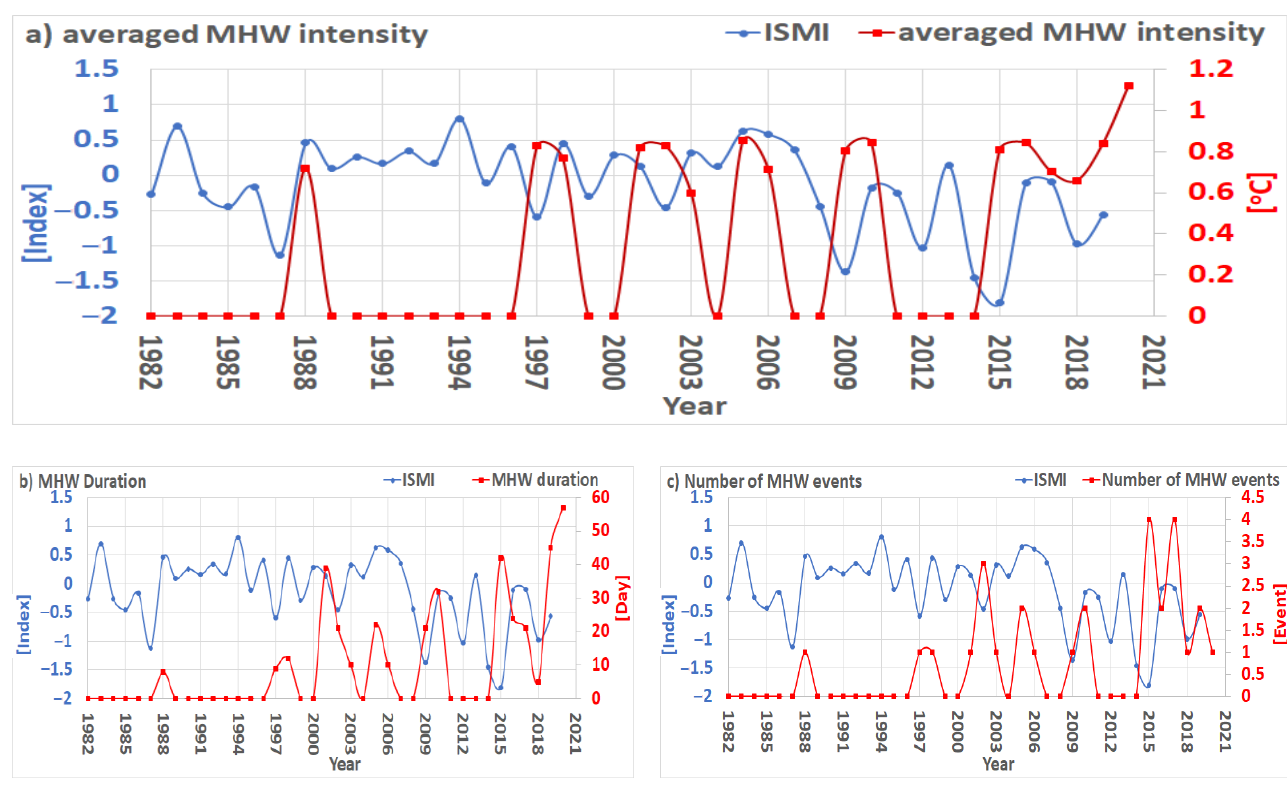
Figure 7. Annual time series of the Indian Summer Monsoon Index (ISMI) over 1982 – 2019 are shown in primary axis. In the secondary axis and in red color, intensity, duration and frequency are shown in ( a – c ), respectively.